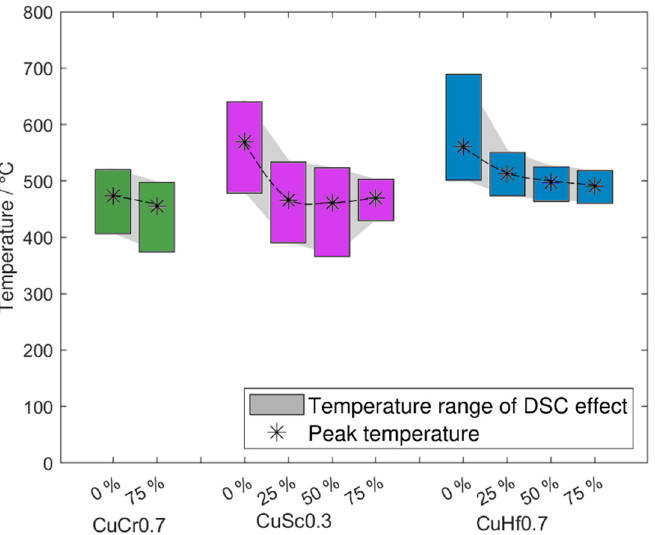
Figure 15. Characterization of the temperature range of the exothermic precipitation effects during DSC measurements of the three alloys analyzed. The bars visualize the first and last deviation of the measured DSC signal to the baseline referring to the precipitation process with the star representing the effects ’ individual peak.